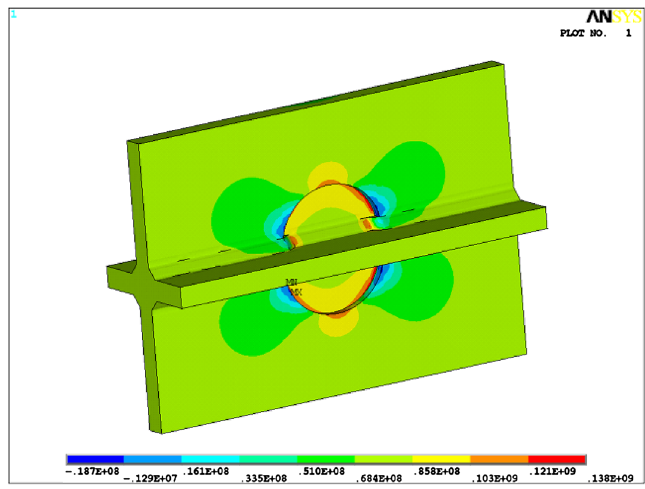
Fig. 5 Finite element results of optimized welded detail